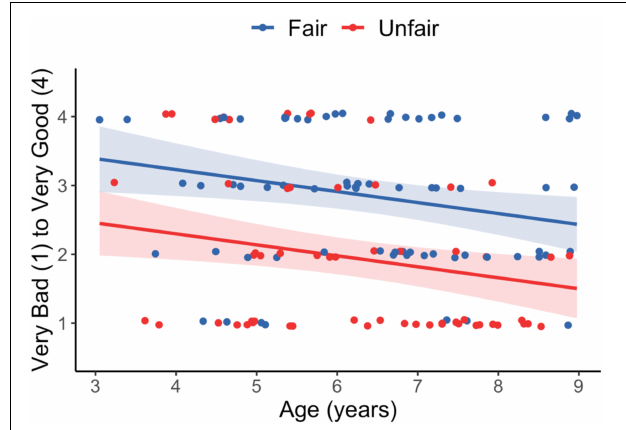
FIGURE 3 | Fairness ratings as a function of Condition and Age. Shaded bands represent 95%